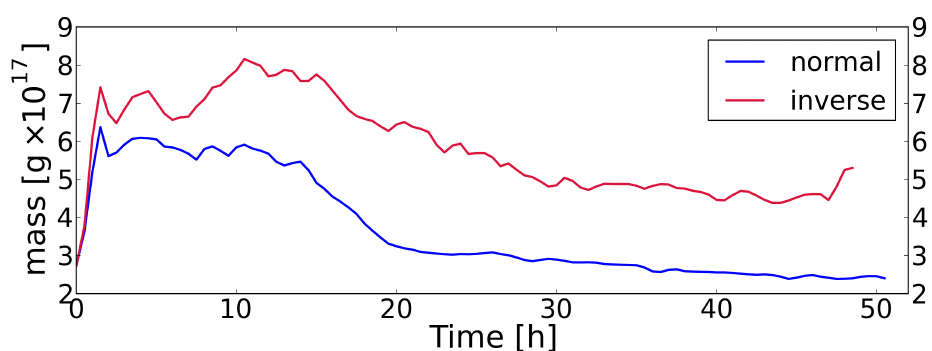
Figure 8. Evolution of the mass of the magnetic cloud for both a normal and an inverse CME with 800 km/s initial velocity propagating through a medium density wind.